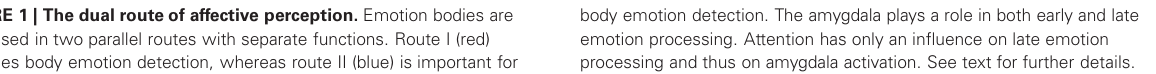
body emotion detection. The amygdala plays a role in both early and late emotion processing. Attention has only an influence on late emotion processing and thus on amygdala activation. See text for further